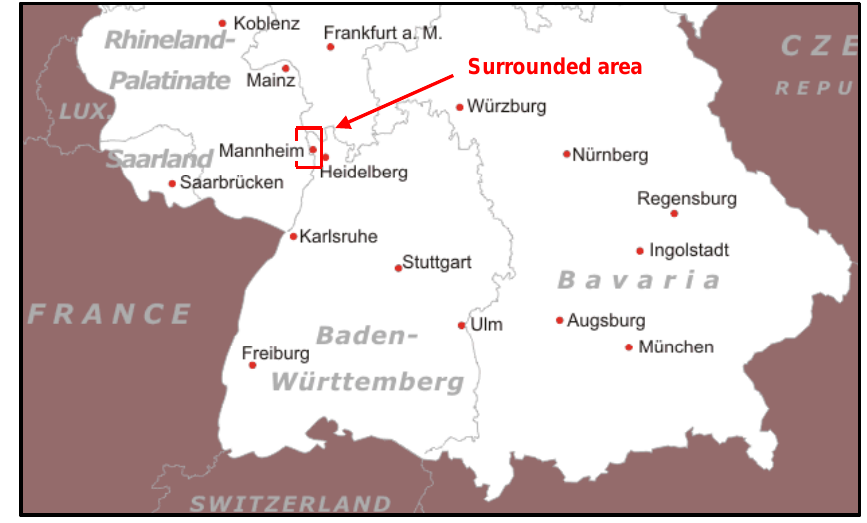
Fig. 3. The red rectangle indicates the location of the encircled area around the cities of Mannheim and Ludwigshafen in southern Germany (see also Fig. 5). (the map was taken from http://www.freeworldmaps.net/europe/germany/political.html).